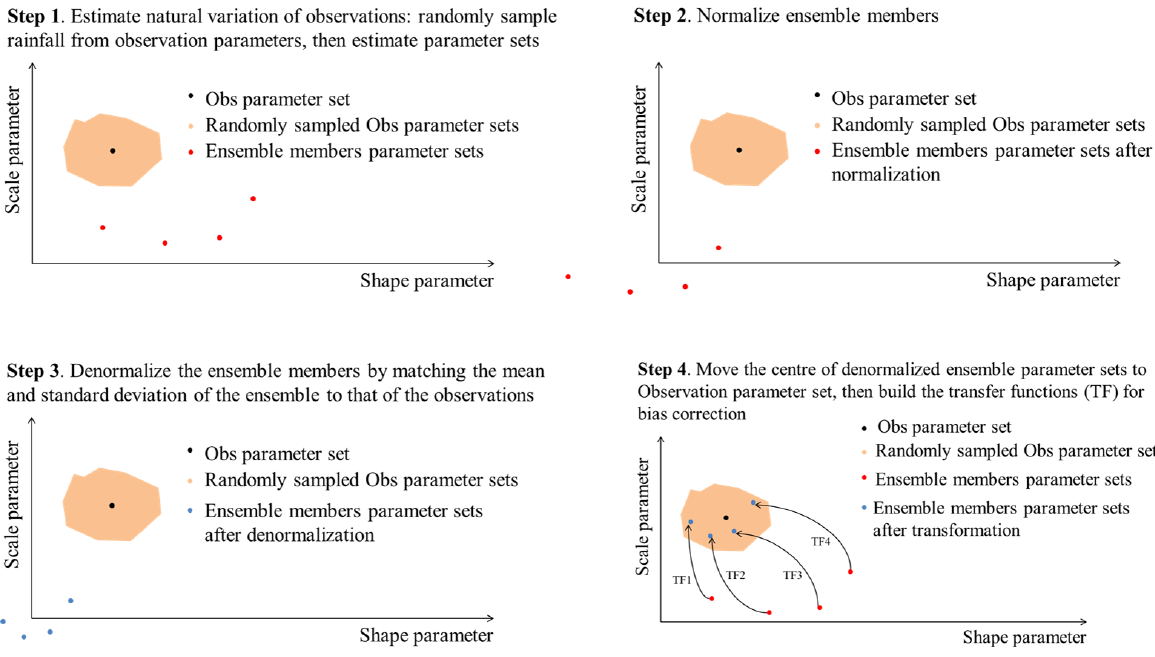
Figure 5. The four-step procedure of the proposed bias correction method.